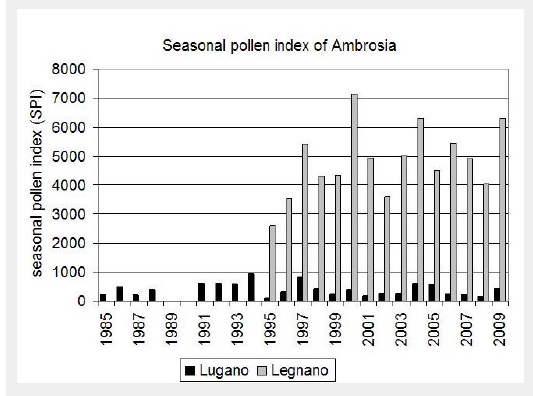
Seasonal pollen index (sum of daily concentrations from July- October) in Legnano (I) and Lugano (CH).